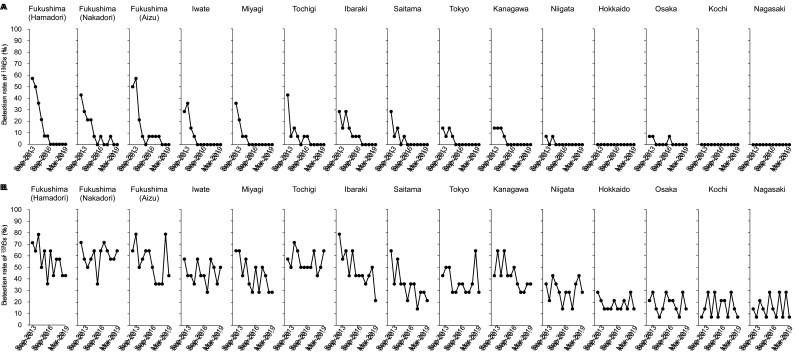
 Time trends of detection rate for r-Cs in each region. Detection rate for
134Cs and 137Cs in each region are shown in A and B,
respectively. Data shown according to the time of study.